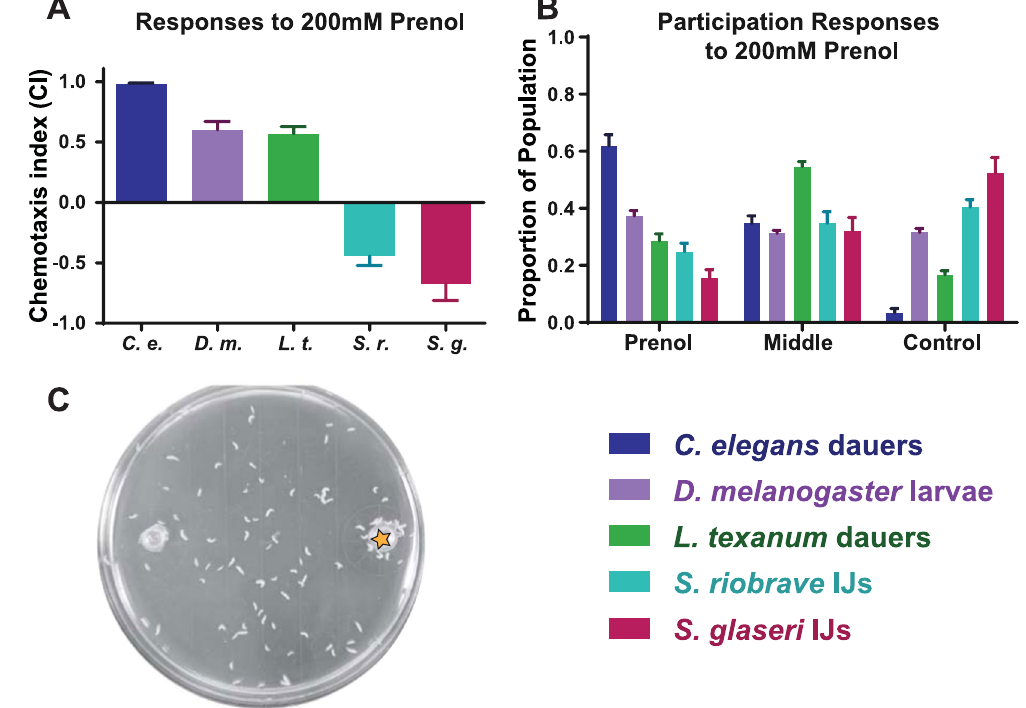
Figure 6. Multi-Species response to prenol. ( A ) Chemotaxis indices for Caenorhabditis elegans (dauers) ( C . e .) Drosophila melanogaster (larvae) (D. m.), Levipalatum texanum (dauers) (L.t.), S . riobrave IJs ( S . r .), S . glaseri IJs ( S . g .). ( B ) The participation values of each of the species tested in ( A ). ( C ) A representative photo of D . melanogaster larvae in response to 200 mM prenol. Star indicates location of prenol (diluted to 200 mM in paraffin